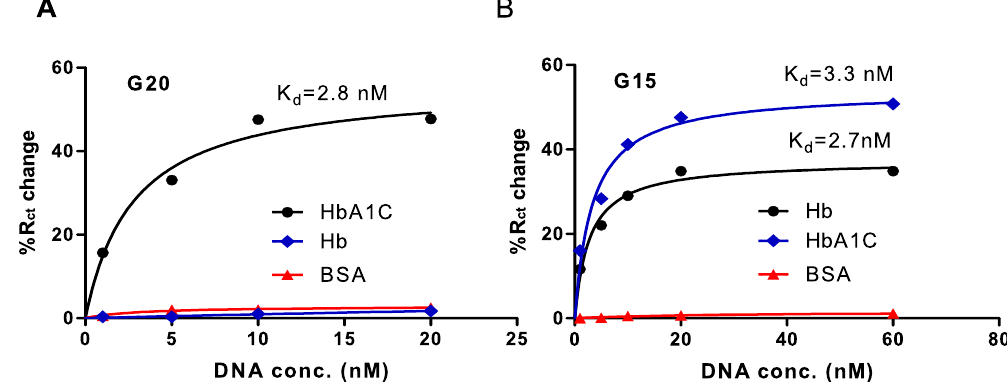
Figure 2. Binding curves of the selected aptamers G20 ( A ) with HbA1c and nonspecific proteins and aptamer G15 ( B ) with Hb, HbA1c and non specific protein.